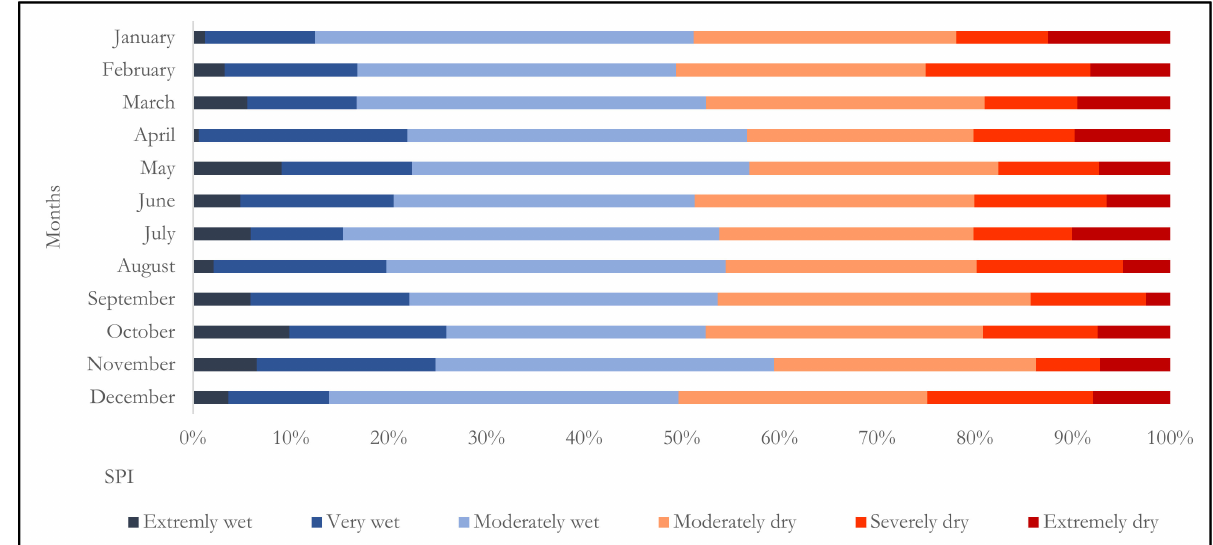
Figure 13. Monthly SPI calculated from study period (1961–2019).